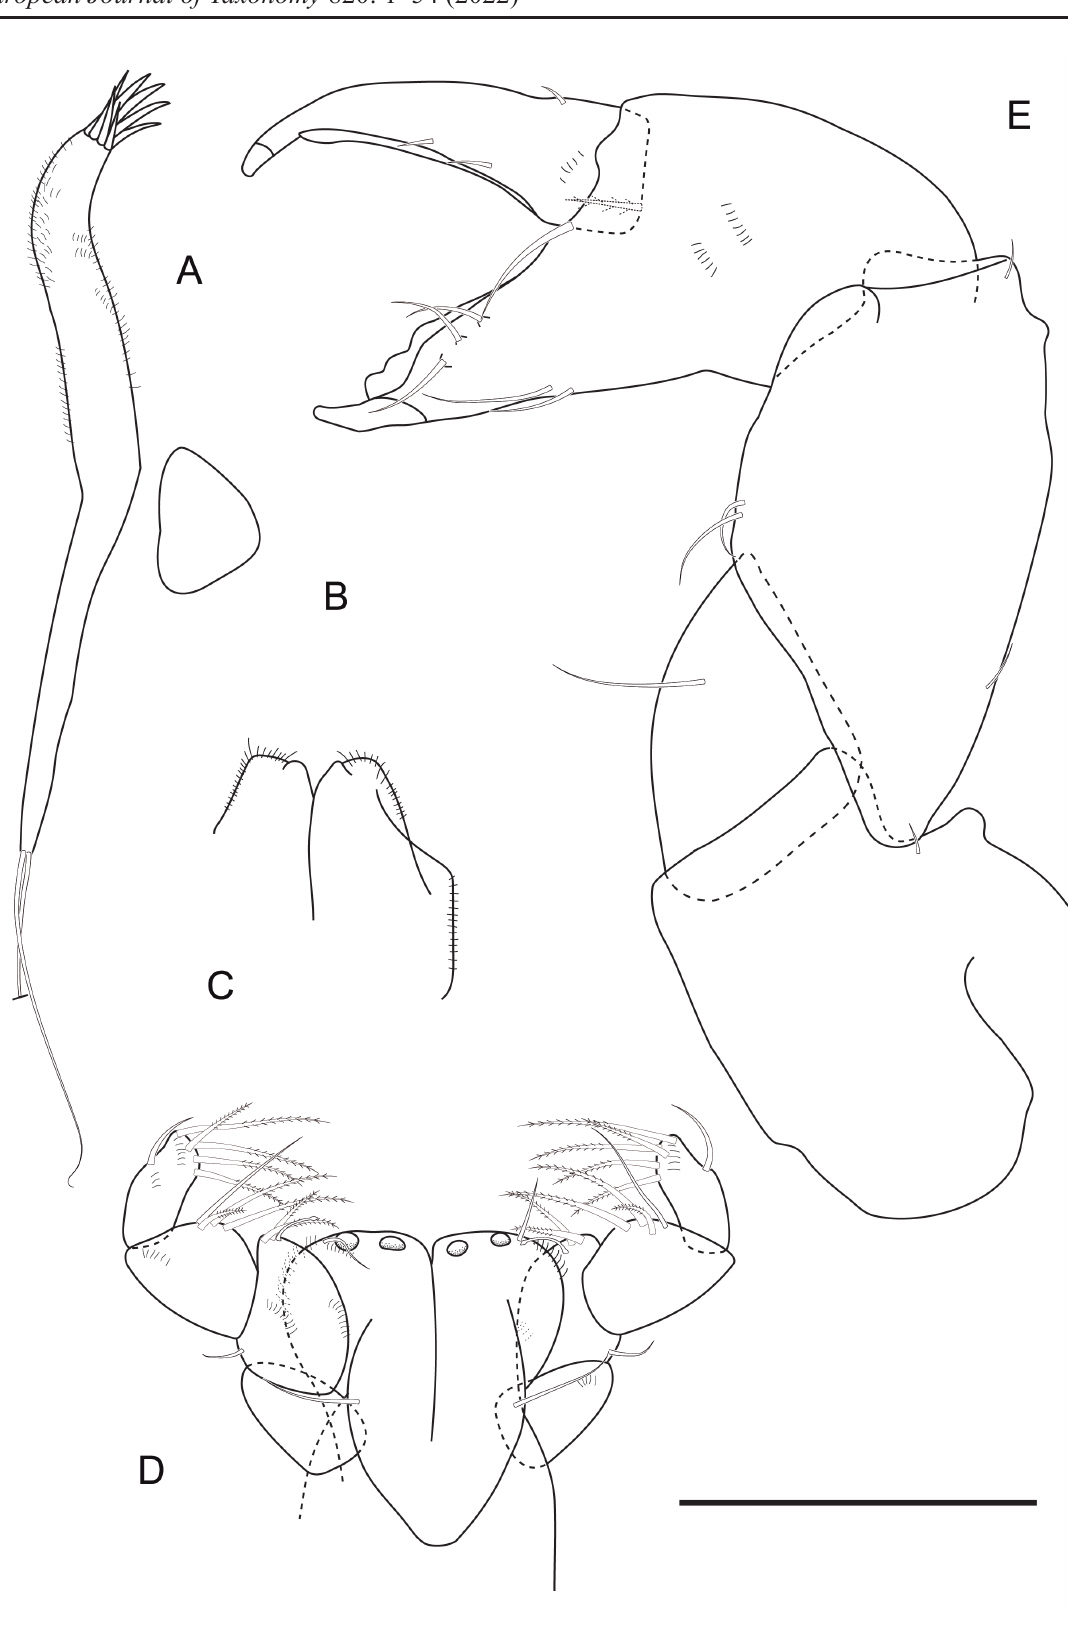
Fig. 18. Typhlotanais spinibasis sp. nov., paratype (MZUSP 32893), ♀, dissected. A . Maxillule. B . Maxilla. C . Labium. D . Maxilliped. E . Cheliped. Scale bar = 0.1